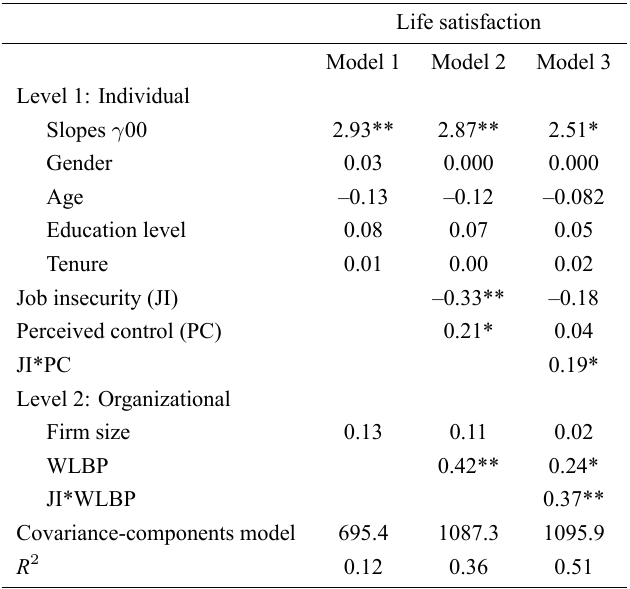
Table 4. Hierarchical linear modeling results